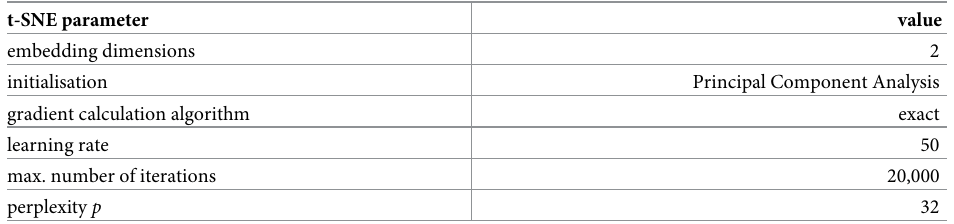
Table 2. Parameters for the t-distributed Stochastic Neighbor Embedding